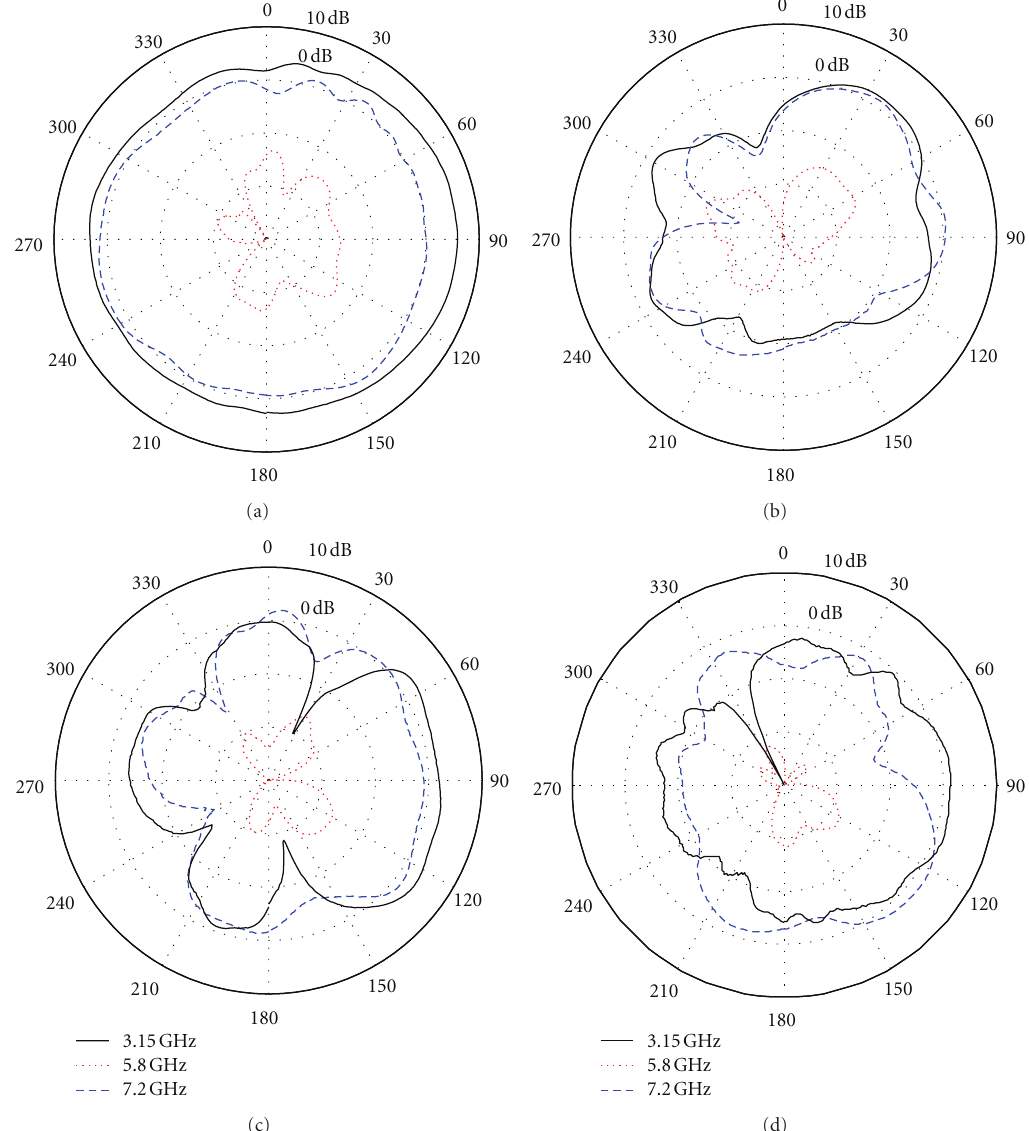
Figure 10: Measured XZ-plane pattern of the proposed antenna for the various mobile terminals, 10 dB per division. (a) Bare-board prototype, (b) slide type, (c) clamshell type, (d) bar